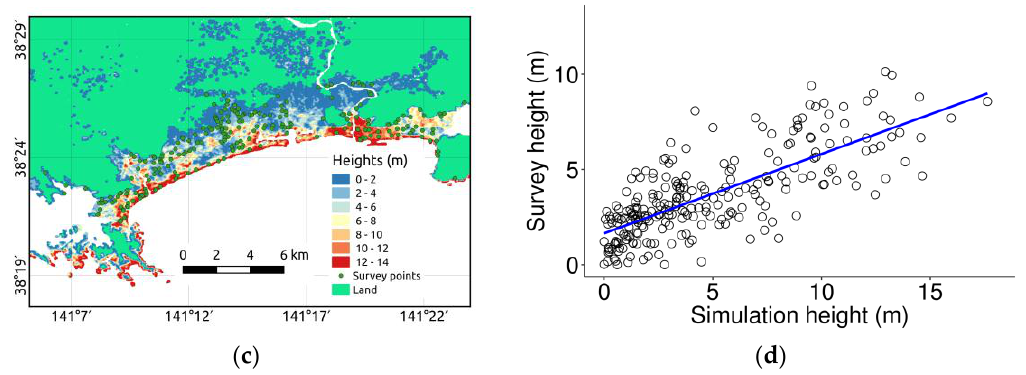
Figure 6. Evaluation of Tohoku tsunami simulation results with post survey data. ( a ) Actual tsunami inundation extent; ( b ) simulation inundation extent; ( c ) survey tsunami height points overlaid on simulated tsunami inundation height map; and ( d ) scatter plot between survey and simulation tsunami height points.